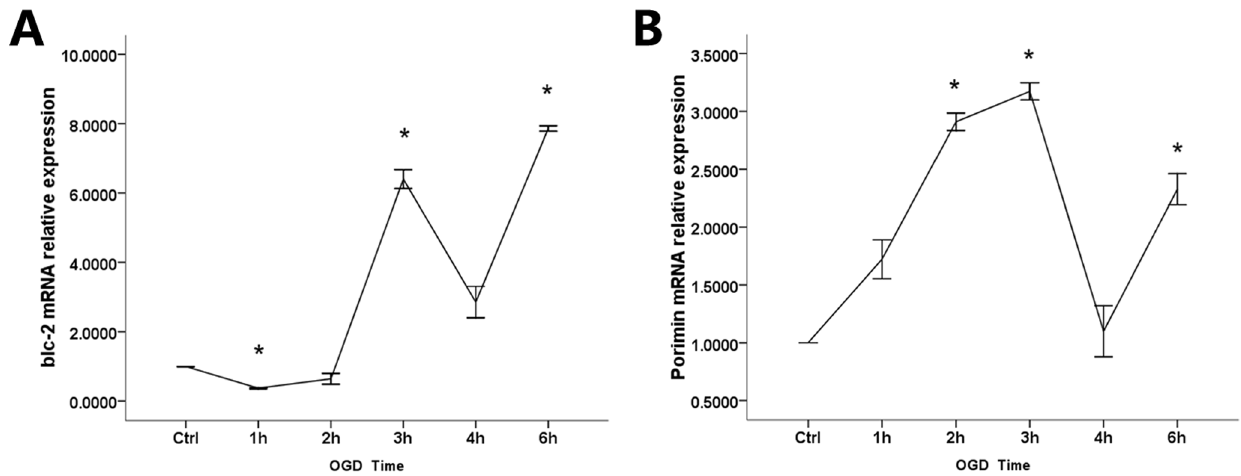
Figure 6. mRNA levels of bcl-2 and porimin in astrocytes exposed to mixed OGD. (A) the bcl-2 mRNA relative expression and (B) porimin mRNA relative expression for 1 h, 2 h, 3 h, 4 h and 6 h were altered relative to the rates of expression in the control samples (0 h). (*) indicates a significant difference (P , 0.05) from the control group.